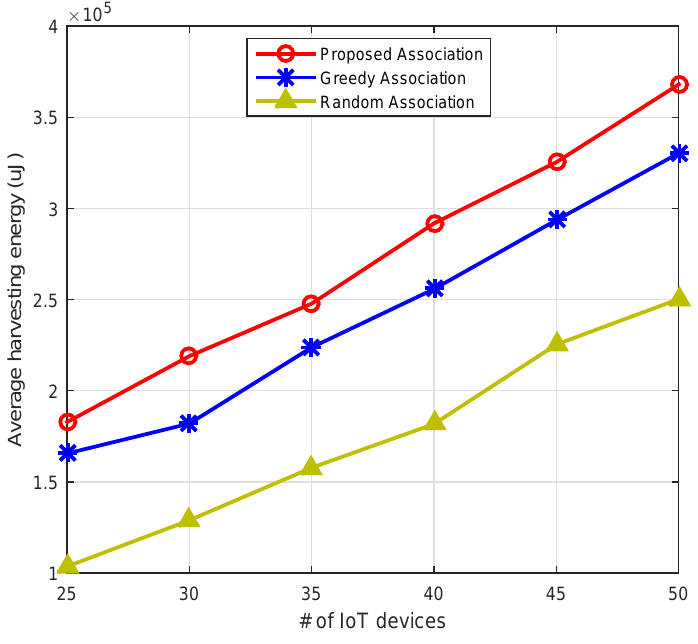
Figure 8. Comparison based on average harvesting